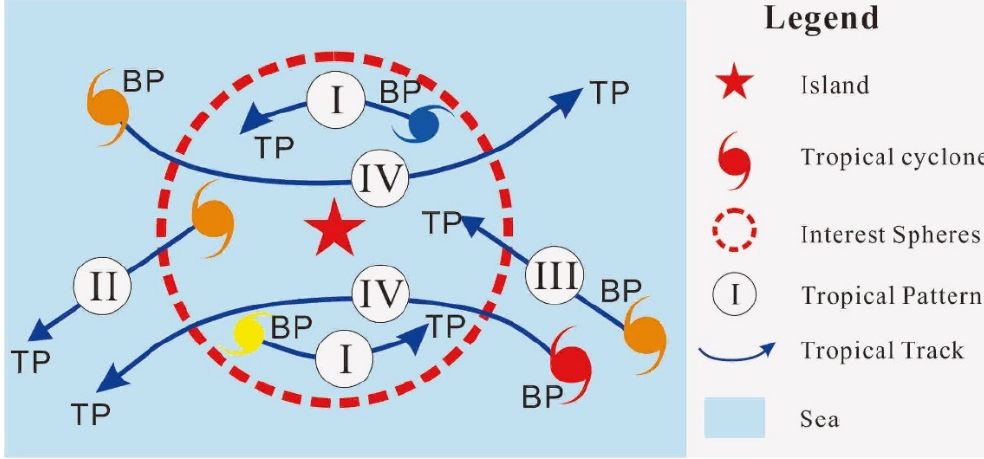
Figure 10. Map of tropical cyclone track patterns.